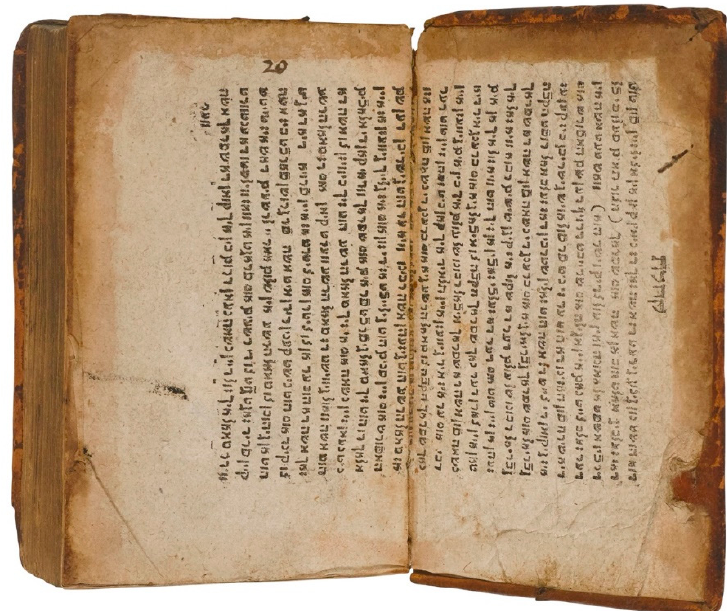
Figure 30. Reused Yiddish Bible (Commentary on Seder Nezikin); Marsh’s Library B.3.4.47.